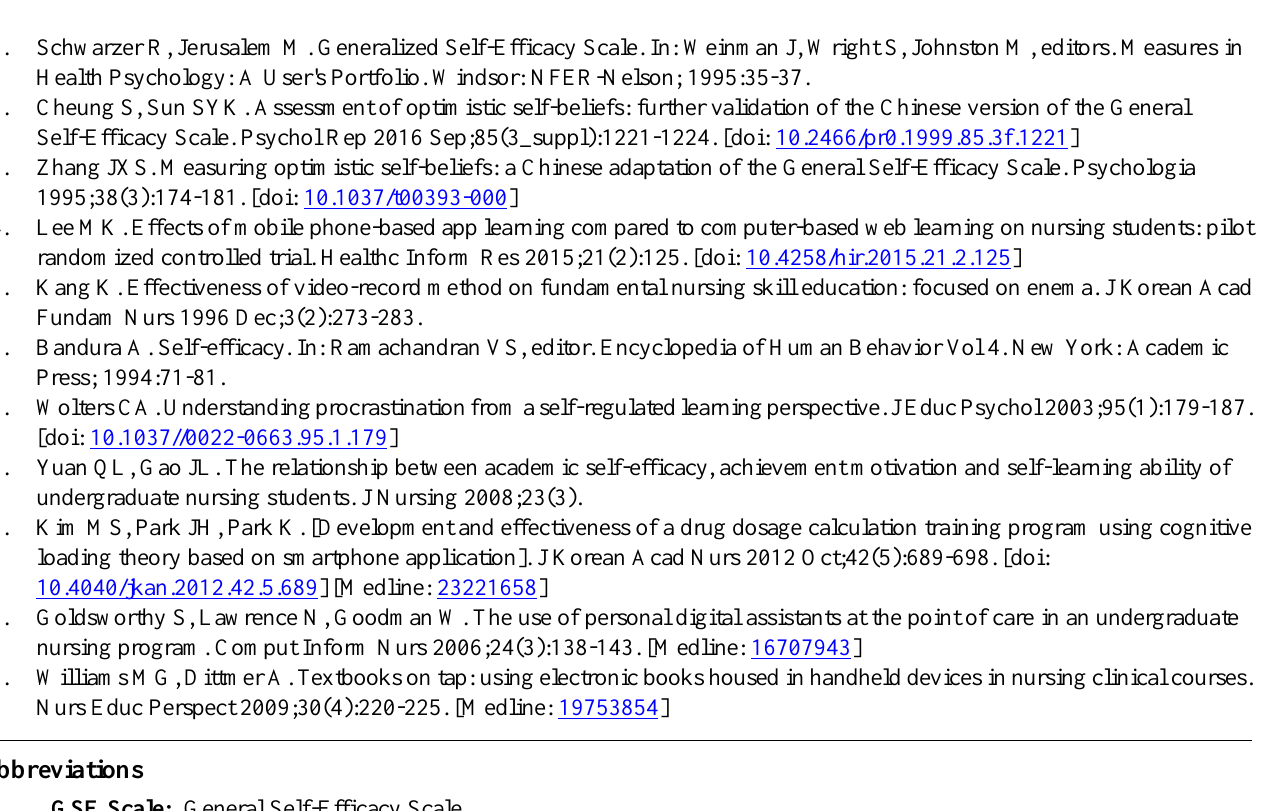
GSE Scale: General Self-Efficacy